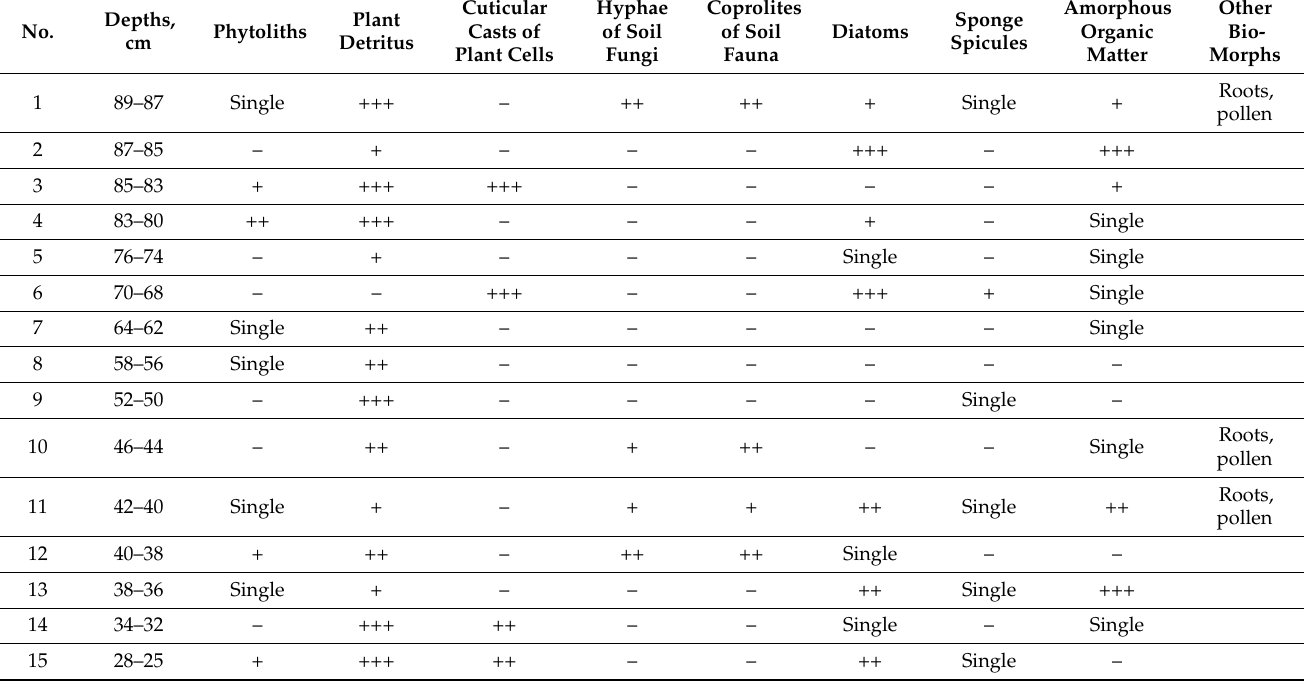
Table 2. The main categories of organic and silica microbiomorphs (in units)